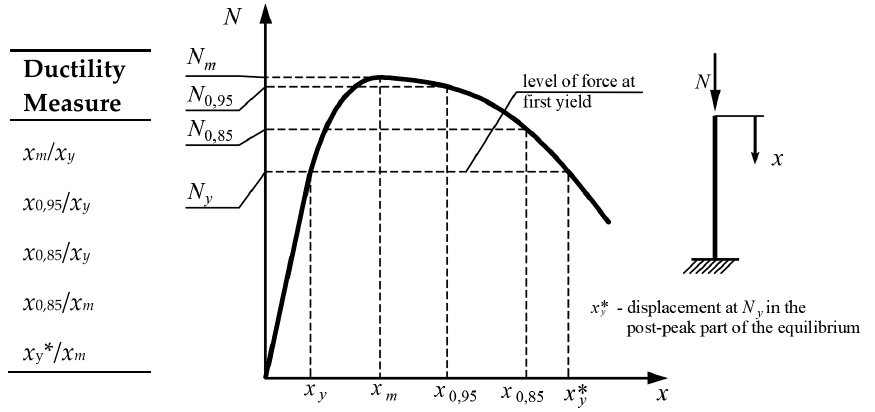
Figure 2. Definitions of vertical displacement ductility factors [12–28].